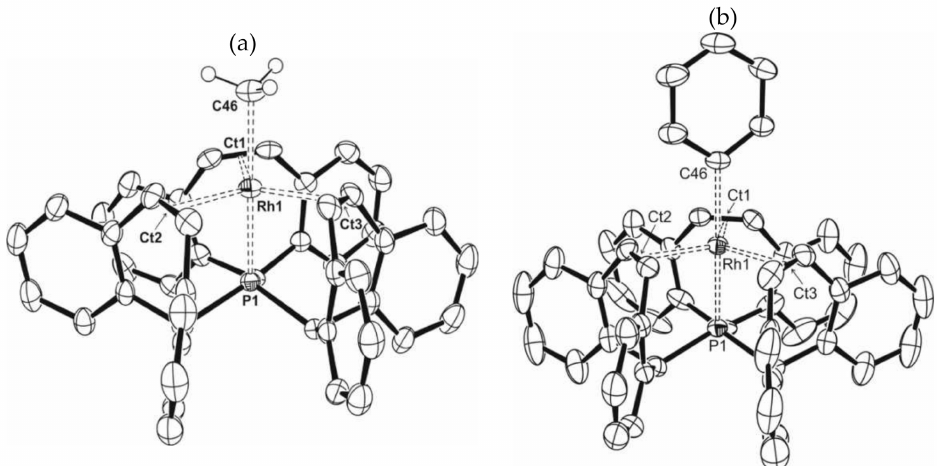
Figure 1. ( a ) Molecular structure of [Rh(CH 3 )(trop 3 P)] × (0.5 C 7 H 8 ) ( 2 ). Hydrogen atoms and solvent molecules (toluene) are omitted for clarity; ( b ) ORTEP plot of [Rh(Ph)(trop 3 P)]x(1.5 C 7 H 8 ) ( 3 ). Hy- drogen atoms, phenyl substituent splitting, and toluene molecules were omitted for clarity. Thermal ellipsoids at 50% probability; selected bond lengths (Å) and angles ( ◦ ): Rh1–P1: 2.2099(7); Rh1–C46: